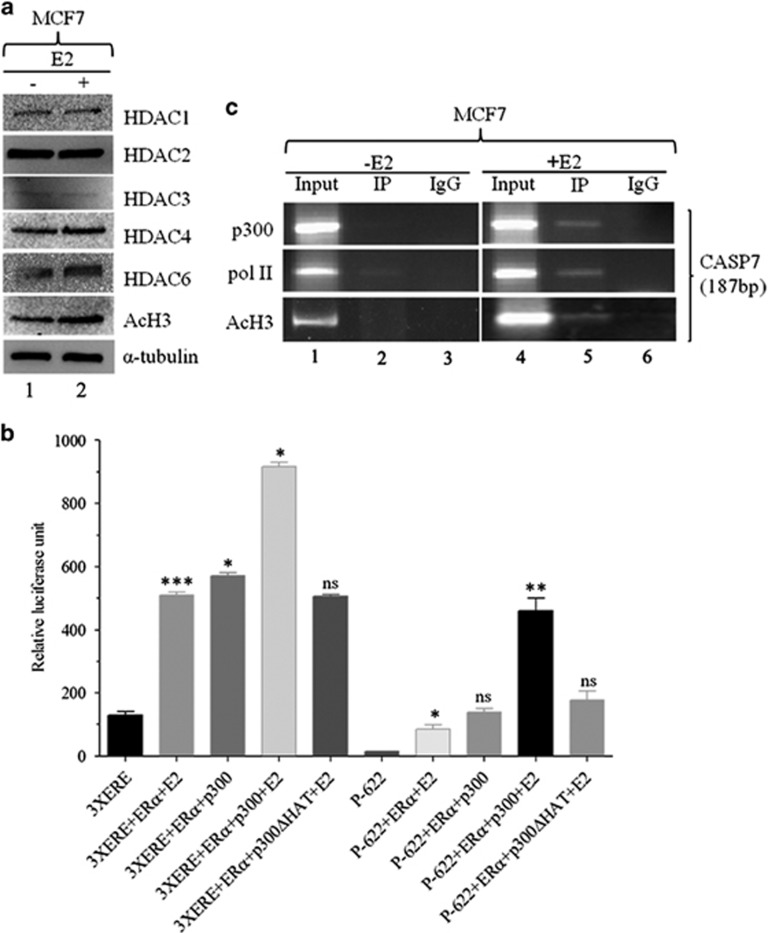
Epigenetic factors positively regulate CASP7 transcription. (a) Western blot of different HDACs and acetylated H3 from whole-cell lysate extracted from MCF7 cells treated with E2 for 48 h. (b) Relative luciferase activities of CASP7 promoter post co-transfection with p300, p300ΔHAT and ERα after 24 h of E2 treatment. (c) Recruitment of p300, pol II and acetylated H3 quantified by Chip PCR in the presence (right panel) or absence (left panel) of E2. *P<0.05. **P<0.01. ***P<0.001.